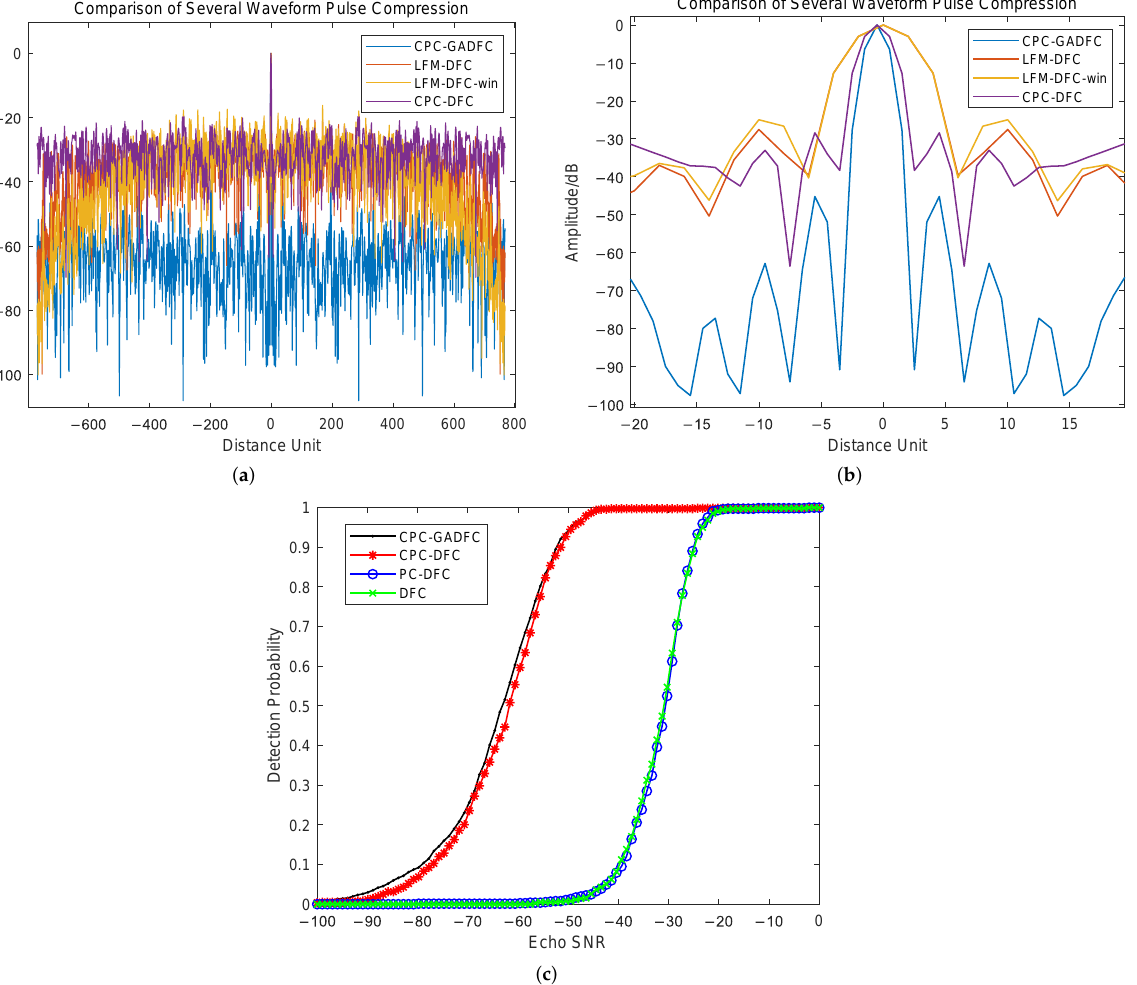
Figure 15. Comparison Diagram of Several Waveform Pulse Compressions and Target Detection Probabilities, ( a ) comparison of the waveform pulse compression, ( b ) enlarged view of the main lobe position of the waveform pulse compression, and ( c ) comparison of the waveform target detection performance. Note that “win” denotes the Hamming